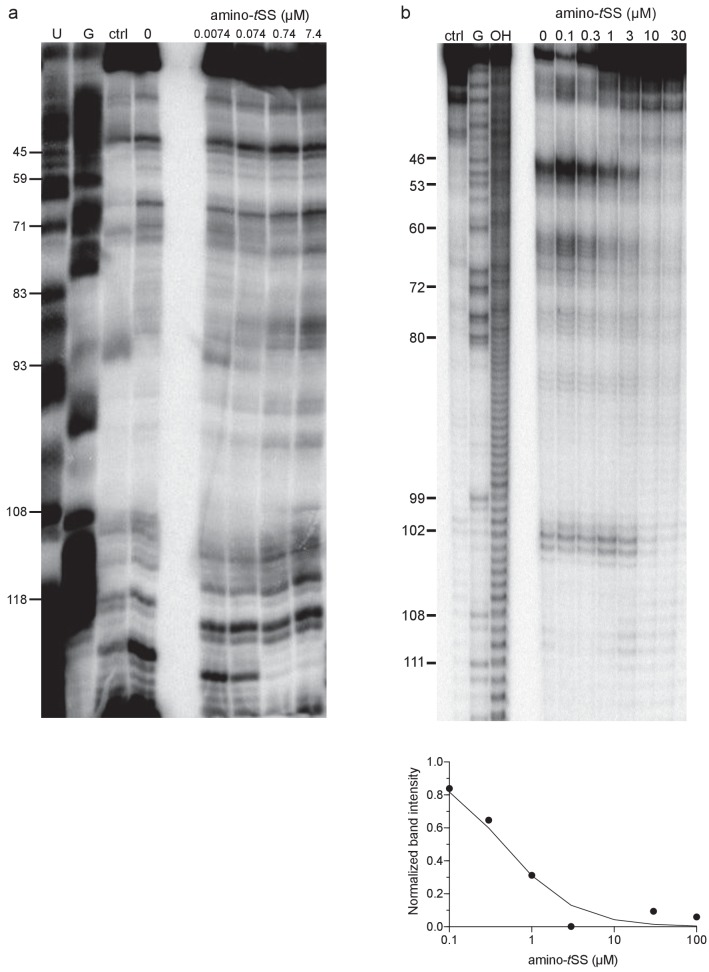
Structural probing of Were-1 in presence of amino-tSS using SHAPE and S1 nuclease digestion.(a) SHAPE analysis of Were-1. Left lanes show reverse transcriptase (RT) stops due to ddA (‘U’) and ddC (‘G’) incorporation for sequence reference, followed by a no-acylation RT control (ctrl) lane, and SHAPE reactions with amino-tSS at concentrations indicated above the gel image. (b) S1 digestion of Were-1. Left lanes contain a control with no RNA (ctrl), RNase T1 digestion for sequence reference, and a partial hydrolysis lane (OH). The right lanes show S1 digestion in the presence of increasing amino-tSS at concentrations indicated above the gel image. Analysis of the band intensity change at positions A44-G46 revealed an apparent KD value of 0.4 µM (below).Figure 1—figure supplement 6—source data 1.Derivation of apparent Kd values from RNA probing data.